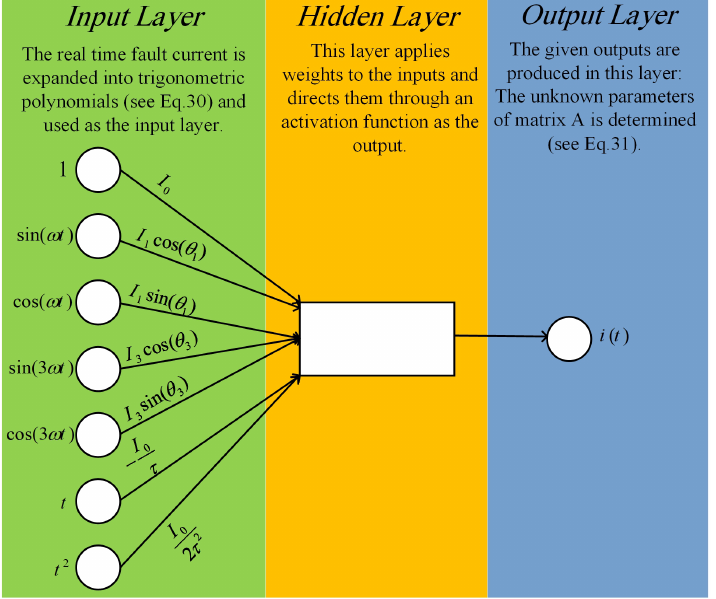
Figure 15. ANN structure for phasor estimation: expanded trigonometric polynomials of the FC signal are considered for the input layer and fundamental phasor components and DDC was obtained as the output